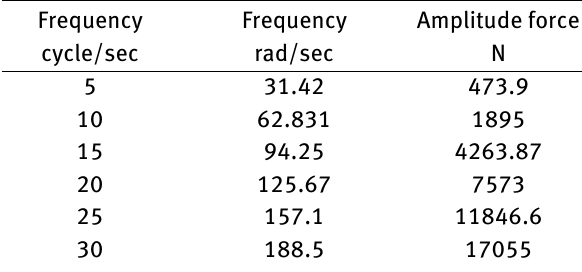
Figure 3: Noise removing, (a) before noise removing (b) after noise removing